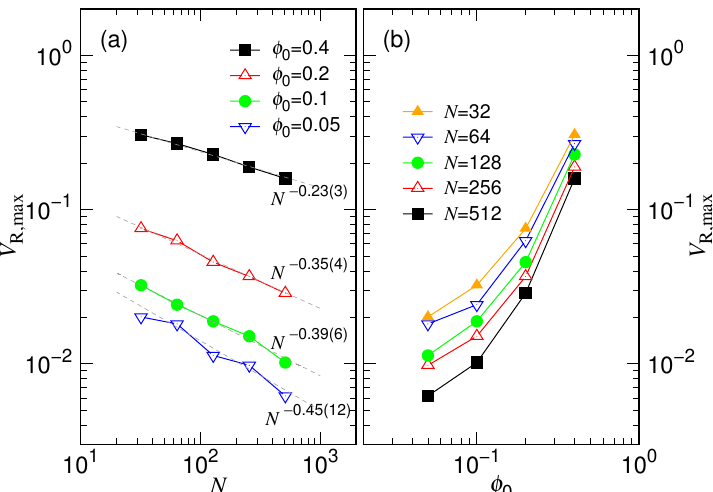
Figure 18. Maximum expansion velocity V R,max as a function of N at a fixed φ 0 (Panel ( a )) and as a function of φ 0 for a given N (Panel ( b )). The value of the fixed φ 0 in ( a ) and the given N in ( b ) can be read in the legend of the